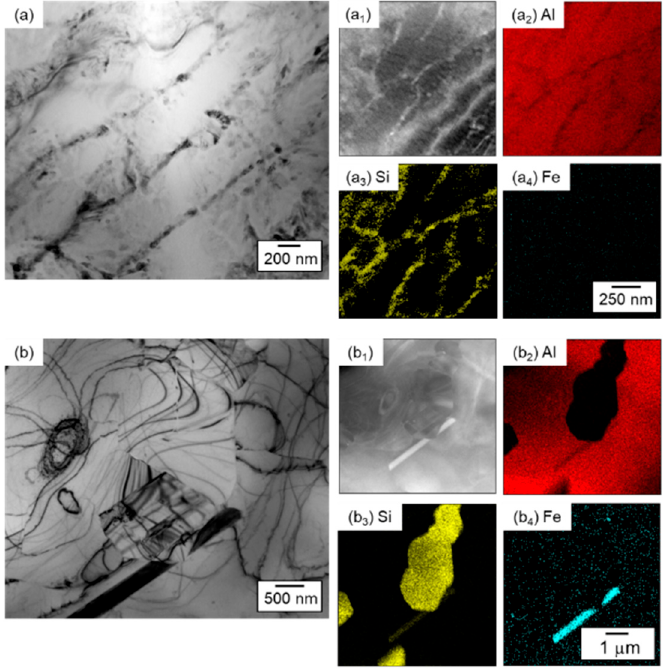
Figure 7. TEM bright-field micrographs showing microstructures of ( a ) as-fabricated and ( b ) 530 °C/6 h annealed samples. ( a 1 , b 1 ) STEM (scanning transmission electron microscopic) images and the corresponding EDS maps of ( a 2 , b 2 ) Al, ( a 3 , b 3 ) Si and ( a 4 , b 4 ) Fe.